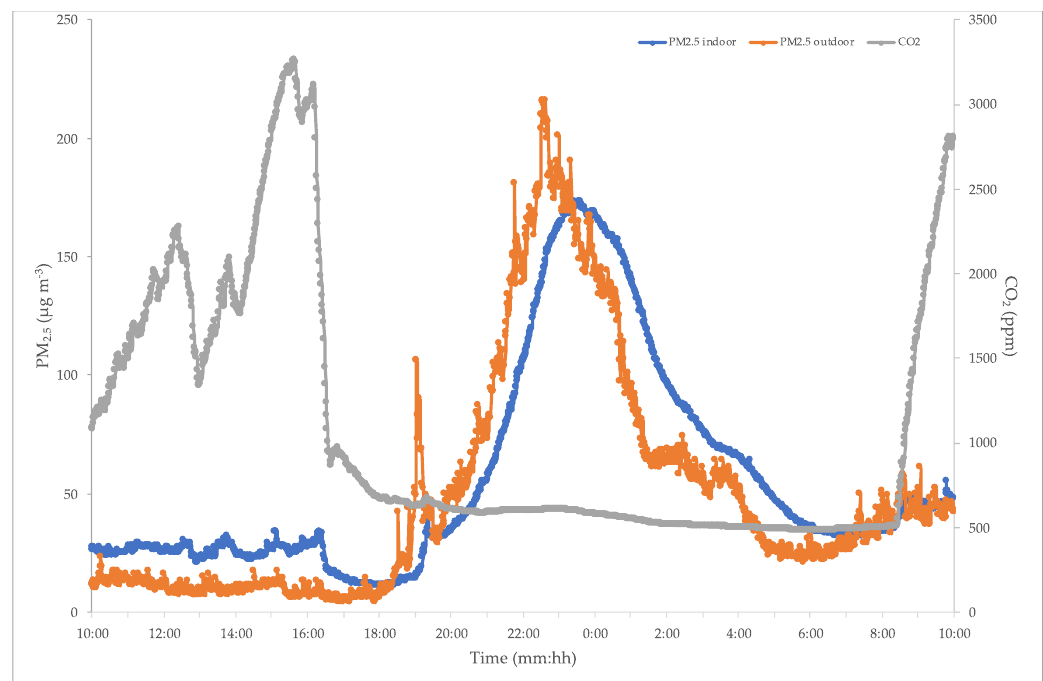
Figure 4. PM 2.5 and CO 2 levels in a class during afternoon/evening events.